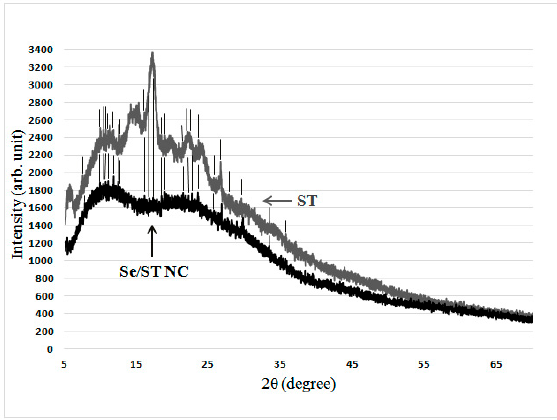
Figure 4. Diffractogram of the Se/ST NC and the original ST (vertical lines depict the Se/ST NC reflexes, which coincide with those for the original ST).